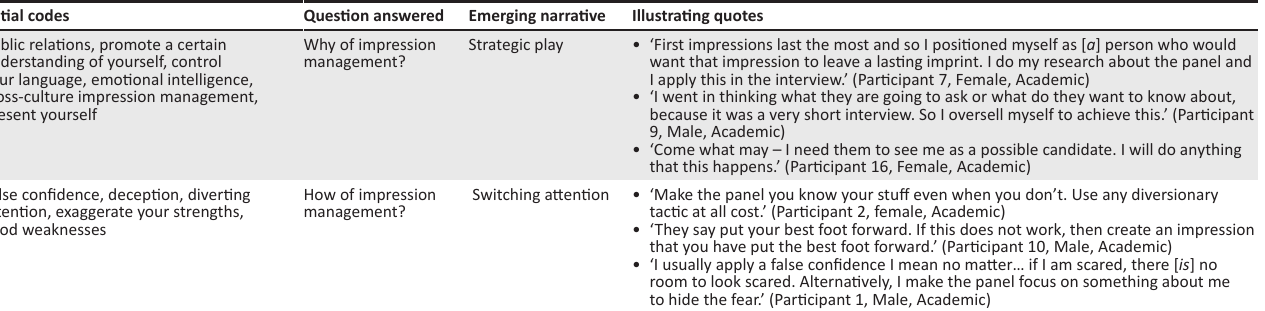
TABLE 3: Data coding process for impression management manifestation during the recruitment process. Initial codes Illustrating